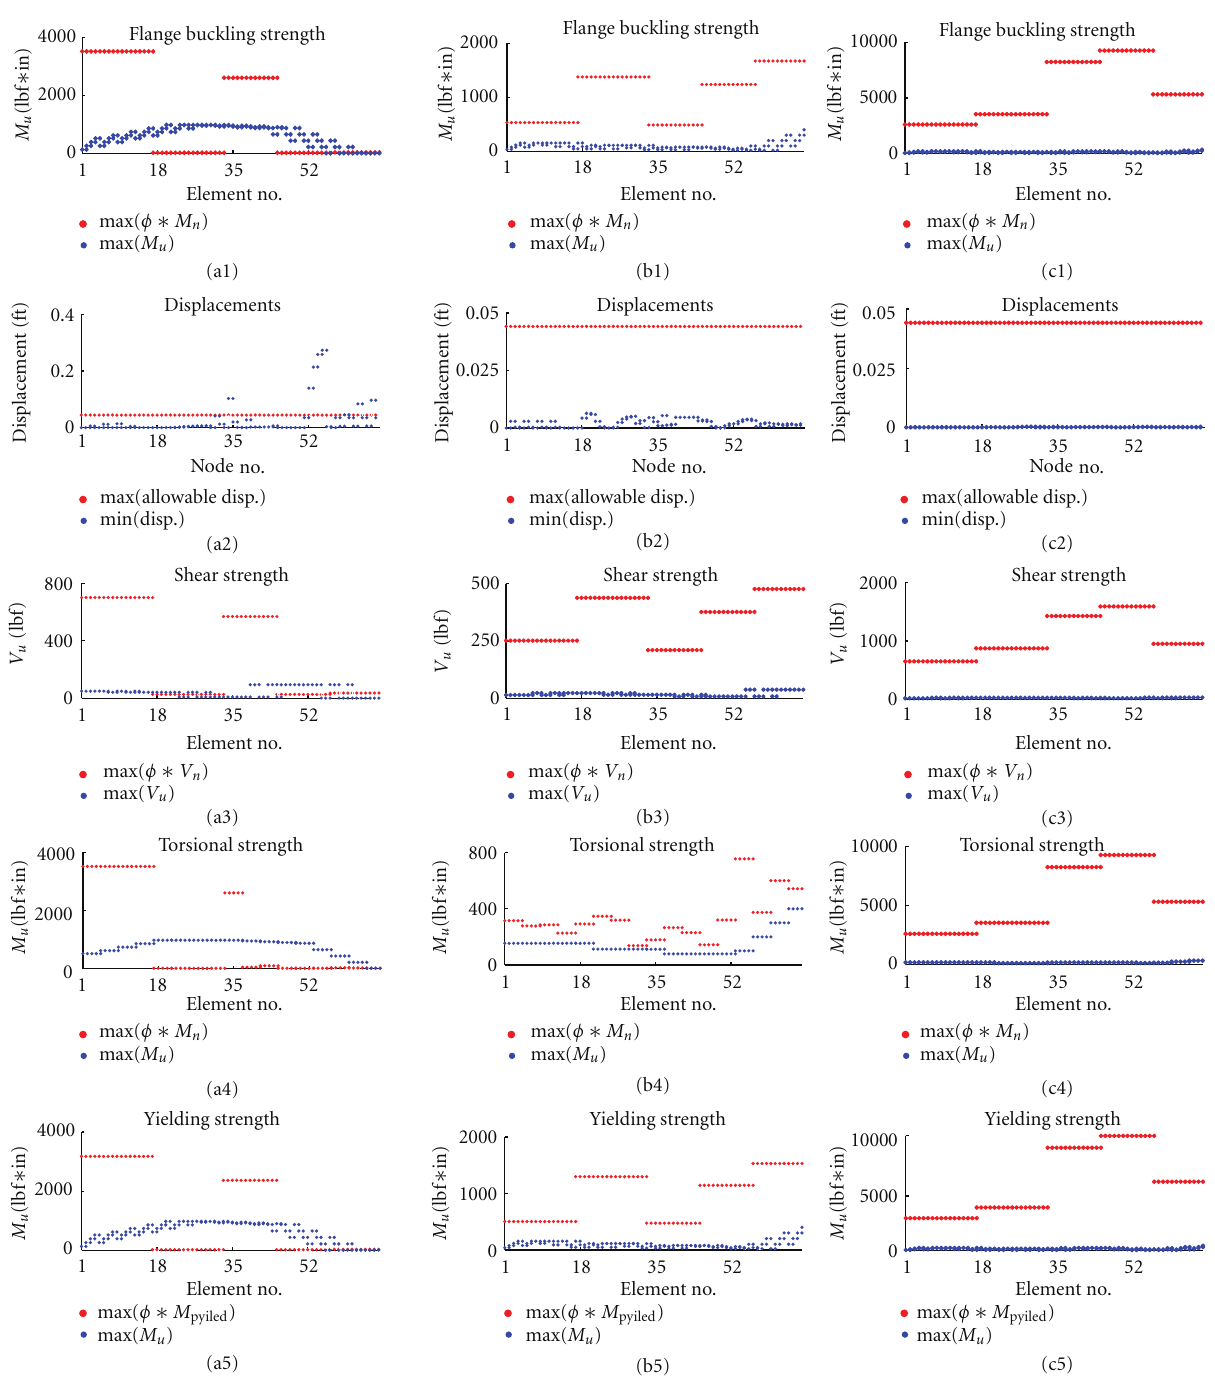
Figure 6: Strengths and displacements of random penalized solutions corresponding to minimum displacement (a1)–(a5), unpenalized solutions corresponding to maximum displacement (b1)–(b5), and maximum weight (c1)–(c5) (see Figure